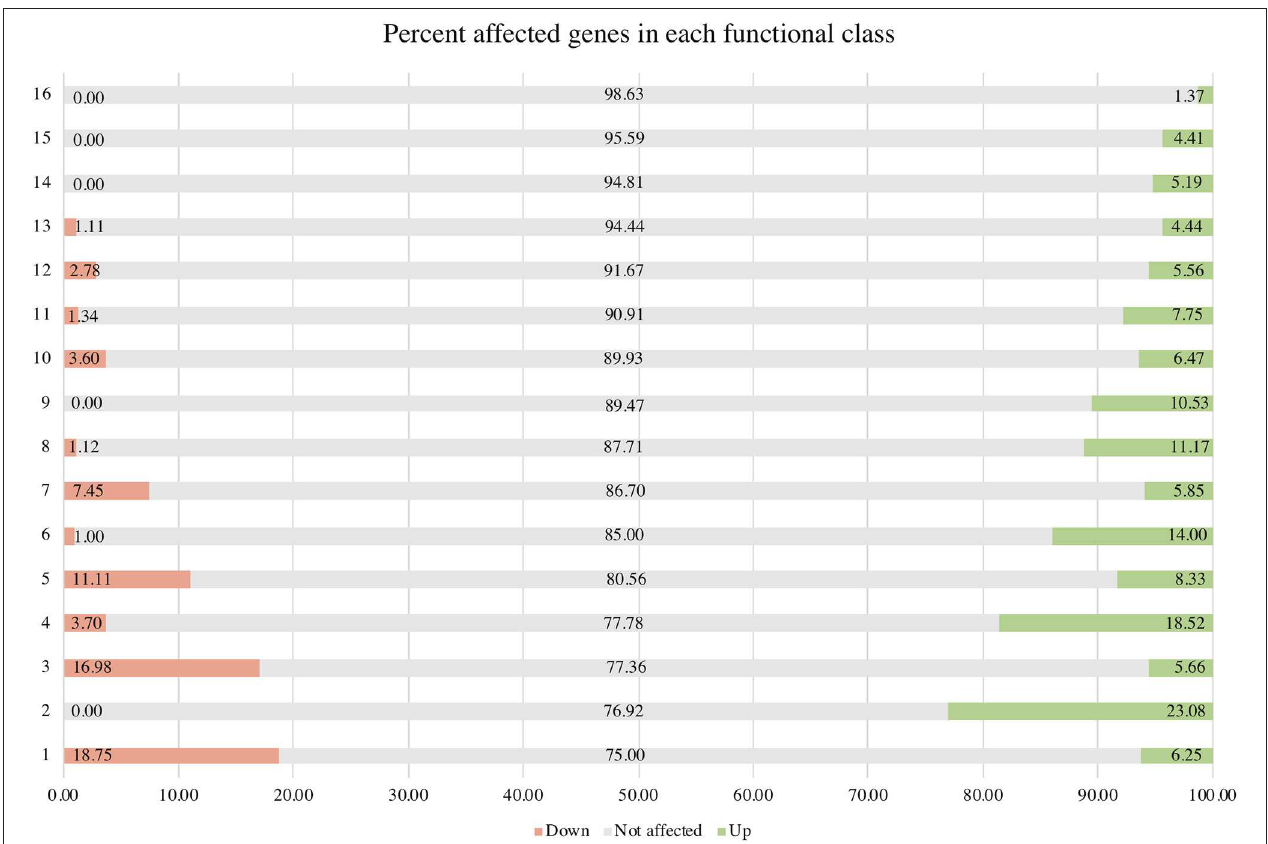
FIGURE 2 | Percentage of positively and negatively σ B -regulated genes in each functional class. Functional classes: 1 = central intermediary metabolism; 2 = purines, pyrimidines, nucleoside, and nucleotides; 3 = amino acid biosynthesis; 4 = cellular processes; 5 = fatty acid and phospholipid metabolism; 6 = cellular proteins; 7 = transporter and binding proteins; 8 = cell envelope; 9 = transcription; 10 = energy metabolism; 11 = hypothetical protein; 12 = biosynthesis of cofactors, prosthetic groups, and carriers; 13 = regulatory functions; 14 = mobile and extrachromosomal element function; 15 = unknown function; and 16 = DNA